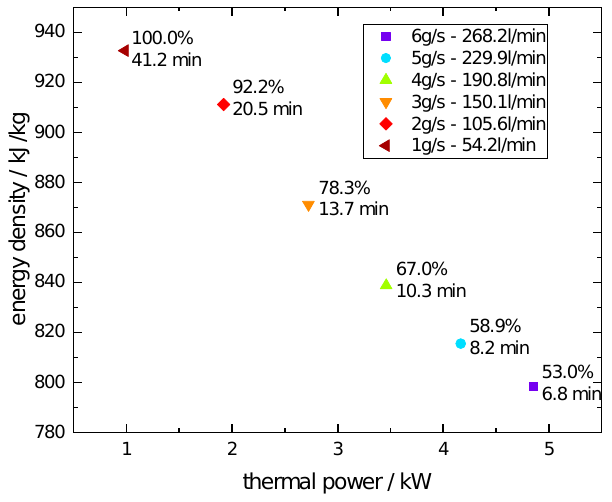
Figure 10. Thermal power of the moving bed reactor for the steady state case and energy density of the Mn-Fe-oxide with different particle flows and gas flow rates. The gas flow rates were chosen for optimized conversion of the particles at the reactor outlet. The overall conversion and the residence time of the particles in the first 10cm after the gas inlet are also